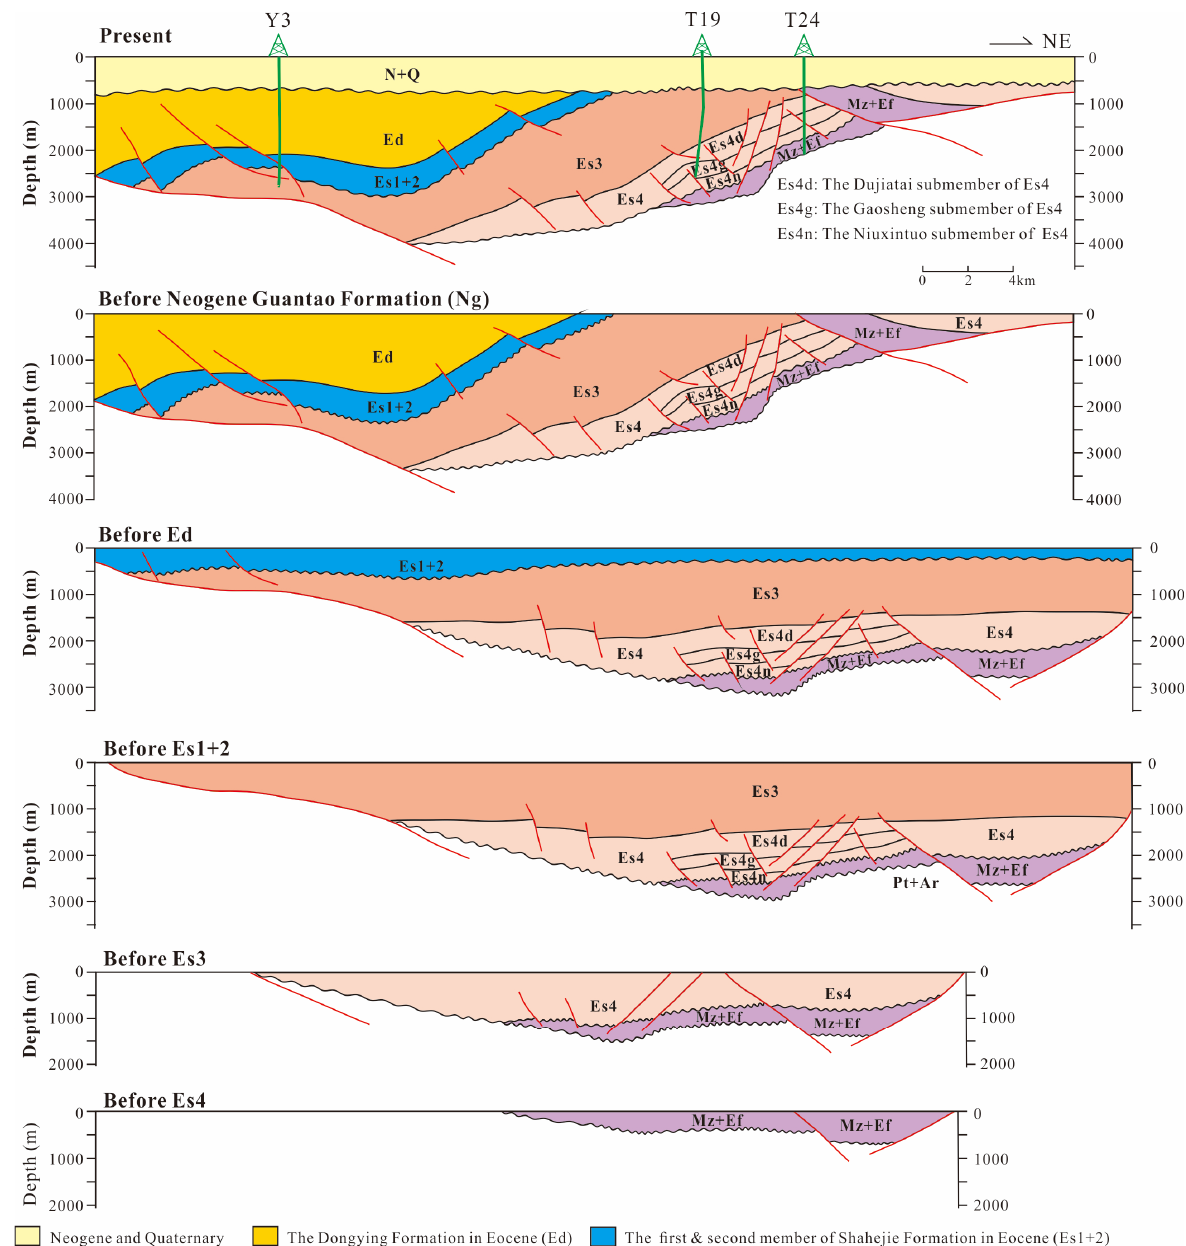
Figure 2. Profile of the tectonic evolution of the Niuxintuo area.